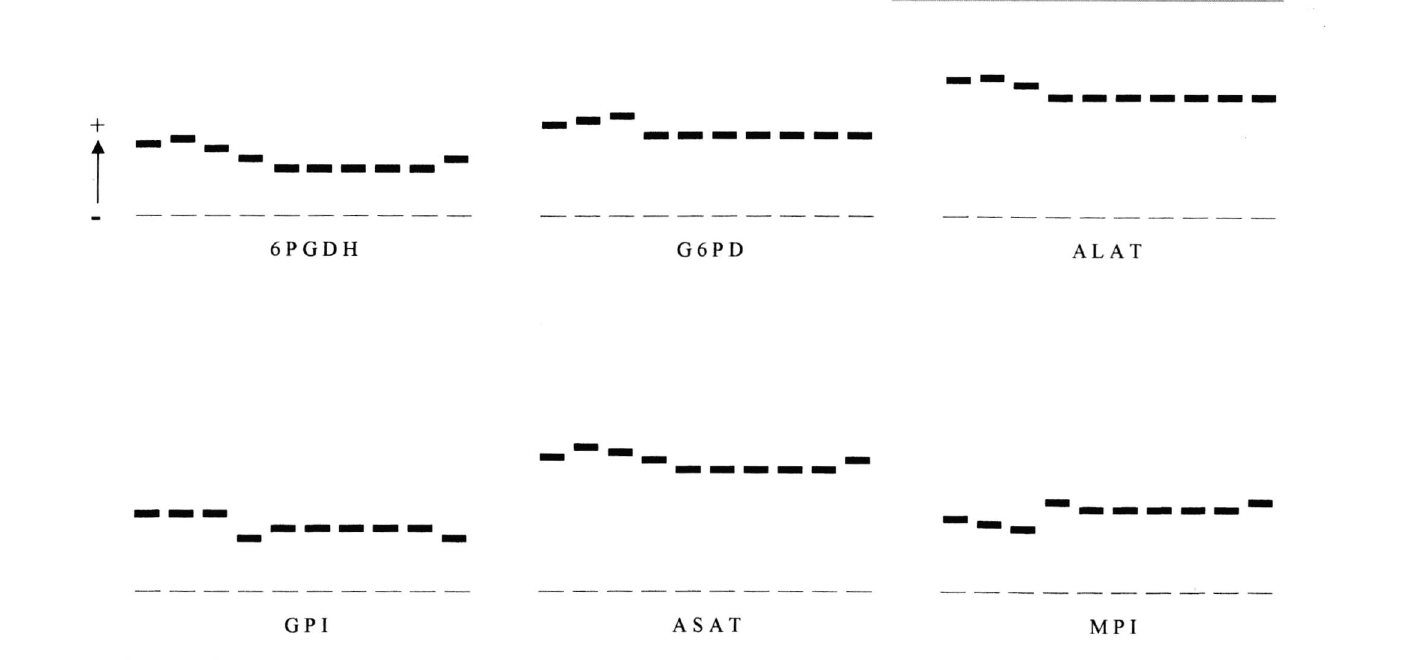
Fig. 6. - Identification of Leishmania (Viannia) lindenbergi n. sp. infecting man, by isoenzyme profiles. Six of 10 enzymes are shown: 6PGDH, G6PU, ALAT, GPI, ASAT, MPI. The parasites compared, from left to right are: 1) L (V.) braziliensis; 2) L. (V.) guyanensis; 3) L. (V.) shawi; 4 and 10) L. (V.) naiffi; 5, 6, 7, 8 and 9) L. (V.) lindenbergi n. sp. Scale: the distance between the points of origin of each parasite is 1,0